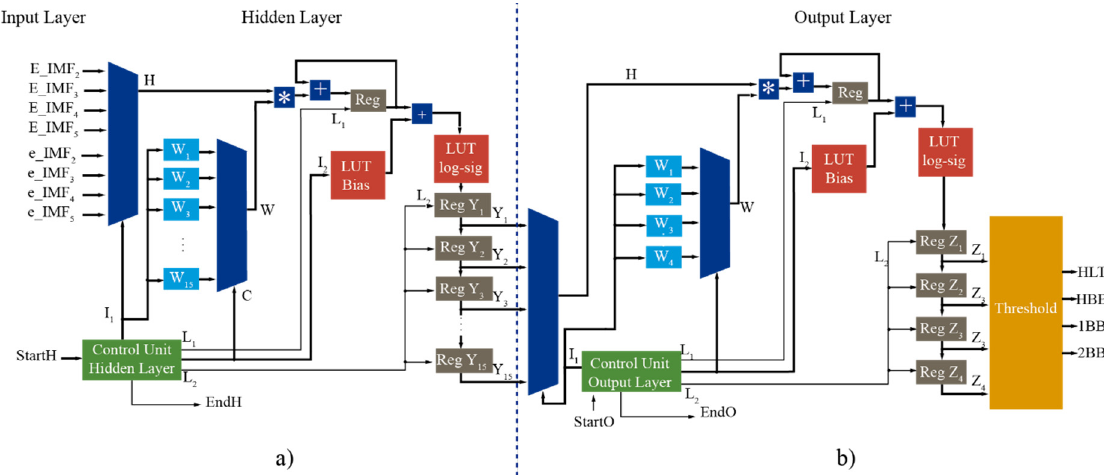
Figure 11. FFNN processor: ( a ) input and hidden layers, and ( b ) output layer.